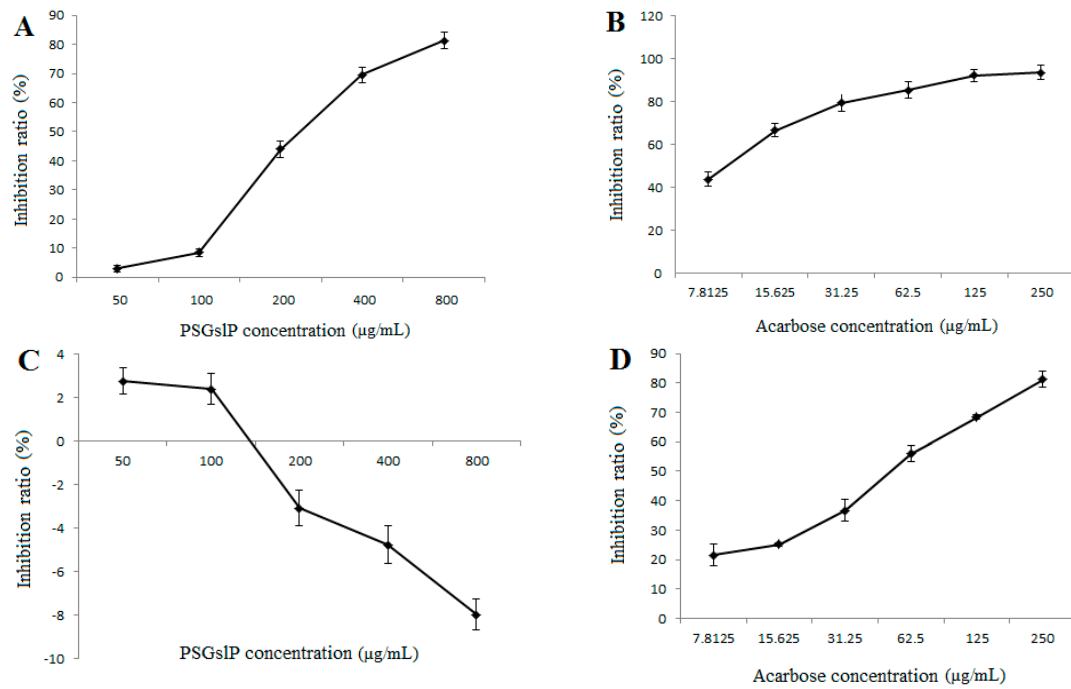
Figure 3. The inhibitory effects of PSGslP on α -amylase and α -glucosidase. ( A ) The inhibitory effect on α -glucosidase; ( B ) The inhibitory effect of acarbose on α -glucosidase; ( C ) The inhibitory effect on α -amylase; ( D ) The inhibitory effect of acarbose on α -amylase.